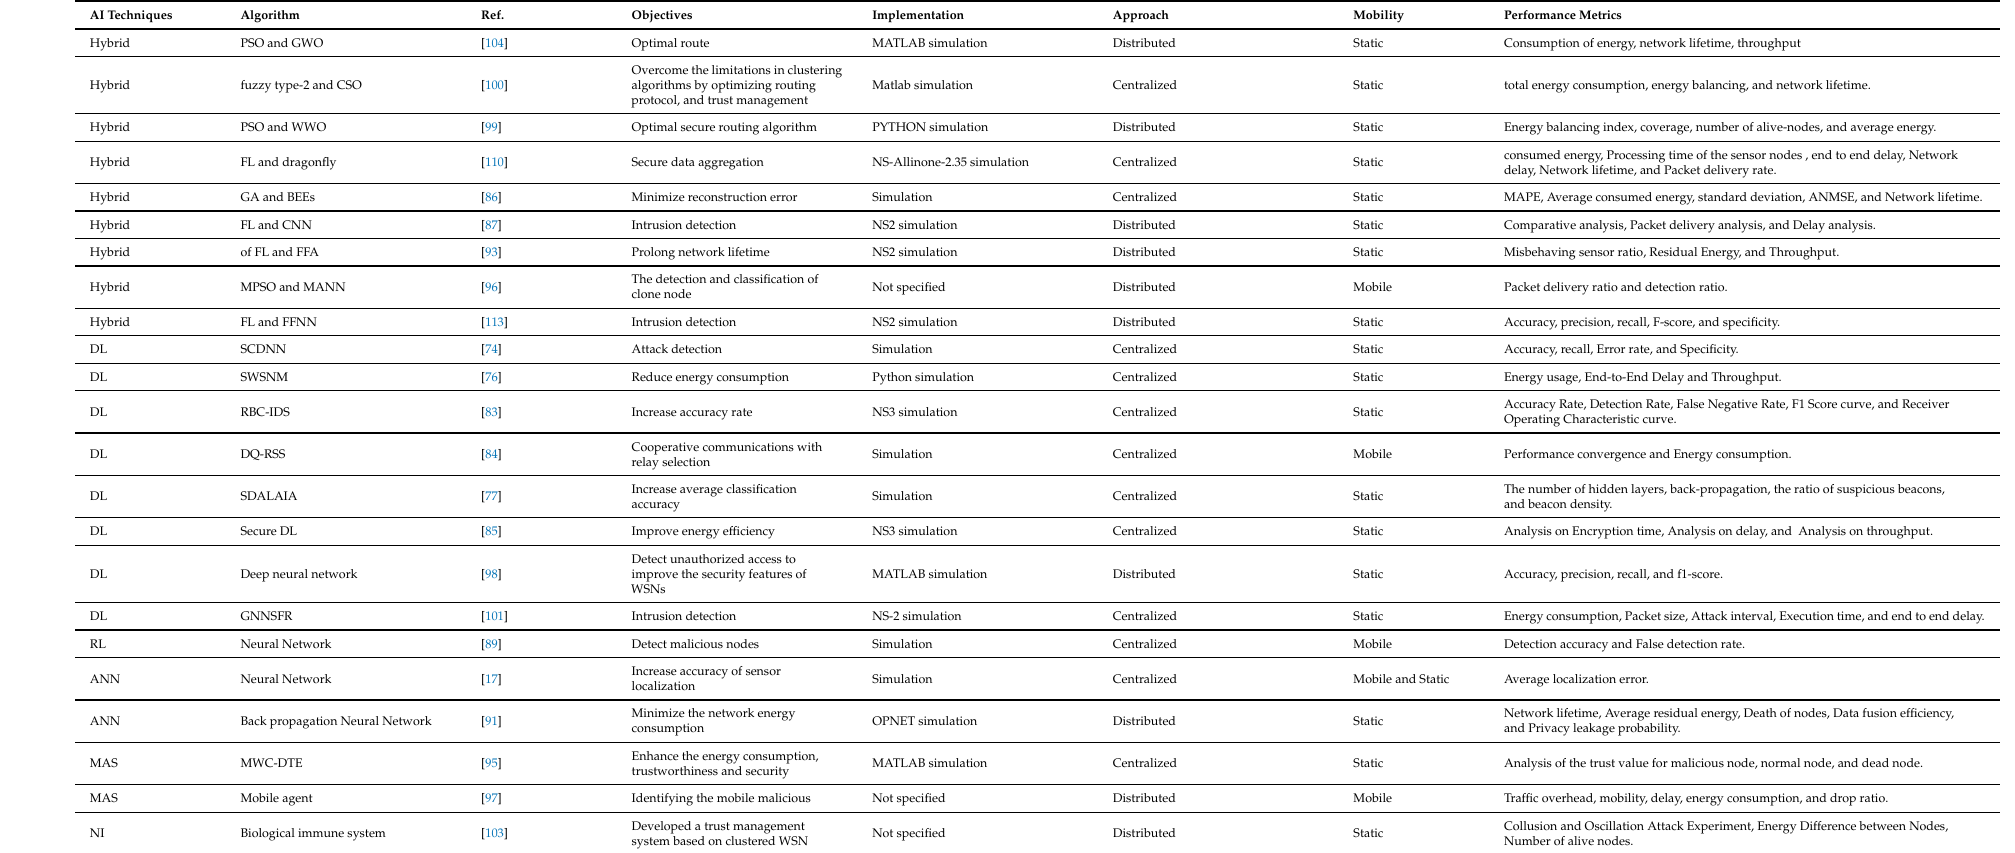
Table 4. Summary of AI-based solutions to WSN security problems discussed in Section